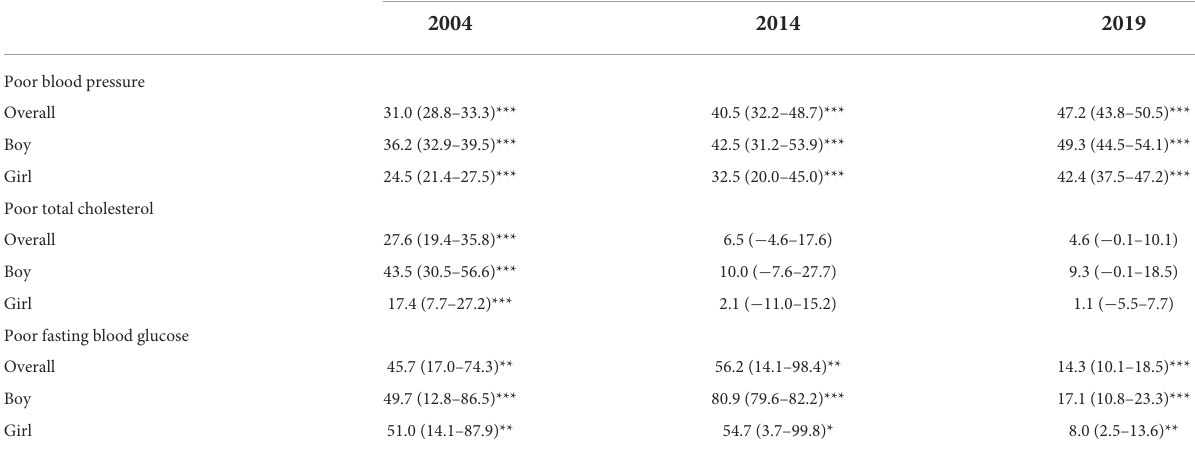
TABLE 7 The change in PAR (%) for CVH factor due to overweight/obesity. CVH